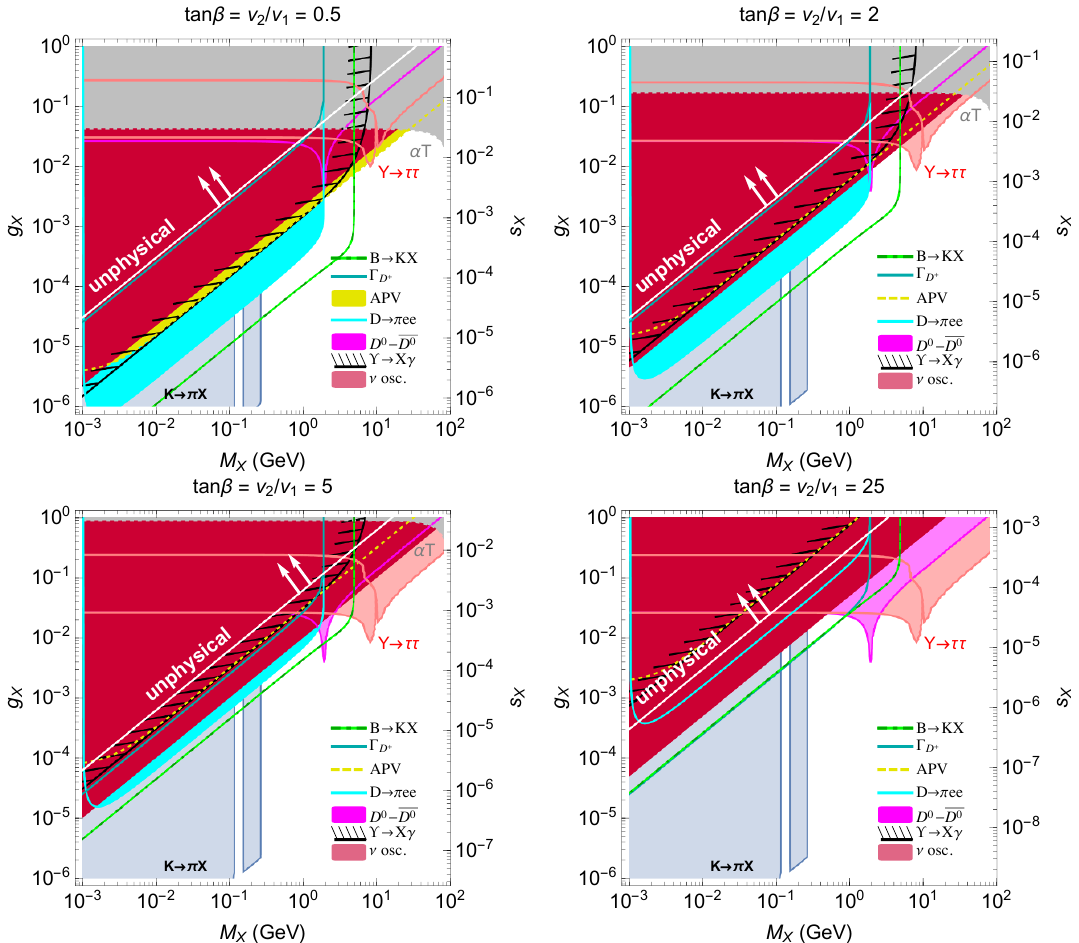
Figure 4. Constraints on the U(1) (3) gauge boson mass M X and coupling g X for tan (cid:12) = B (cid:0) L 0 : 5 ; 2 ; 5 ; 25. For convenience the X (cid:0) Z mixing, s X , is also shown. Notice that for a given g X , the mass of the gauge boson M X is bounded from below, so there is an unphysical region in the upper left corner of the M X (cid:2) g X plane (delineated by the white line). The \ (cid:23) osc." bound comes from non standard interaction e(cid:11)ects (matter potential) on atmospheric neutrinos. \APV" refers to atomic parity